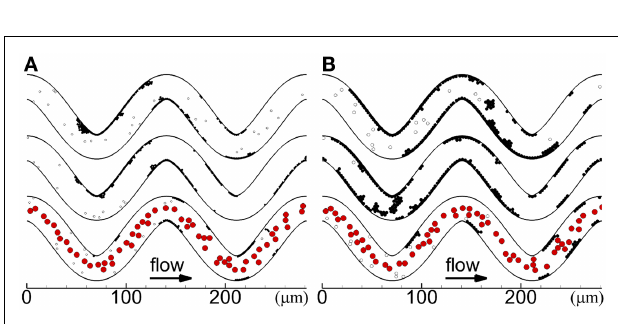
FIGURE 4 |Time variation of activation count during an early stage, for the low tortuosity (A) and high tortuosity (B) arterioles; and during the entire simulation time for the high tortuosity arteriole (C), for Cases 2–6 .